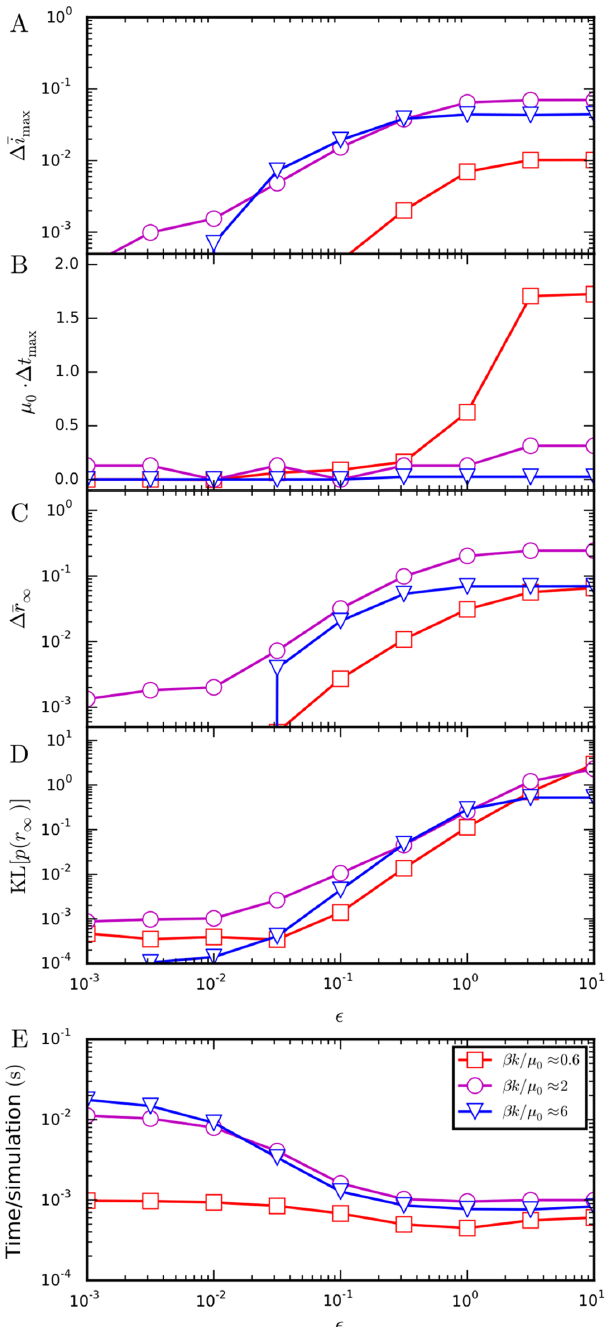
Fig 8. Accuracy and speed of the non-Markovian temporal Gillespie algorithm as function of (cid:2) . (A) – (D) Different measures of the difference in outcome of simulations between algorithms with (cid:2) > 0 and (cid:2) = 0 (quasi- exact). (A) Difference, D i max ¼ i max ð (cid:2) Þ (cid:5) i max ð 0 Þ , in the peak average fraction of infected nodes, i max ¼ I max = N . (B) Difference Δ t max between the times at which this peak takes place, normalized by μ 0 . (C) Difference, D r in the average fraction of nodes affected by the infection — the average attack rate . (D) Kullback-Leibler divergence, KL[ p ( r 1 )], between the distributions of attack rates (E) Time per simulation of the process. Simulations were performed on an activity-driven network with N = 100 nodes and activities a i = z i /10 with z i (cid:4) z i 2 [0.03, 1); nodes ’ recovery times followed Eq (23) with γ = 1.5, μ z (cid:5) 3 : 2 i for